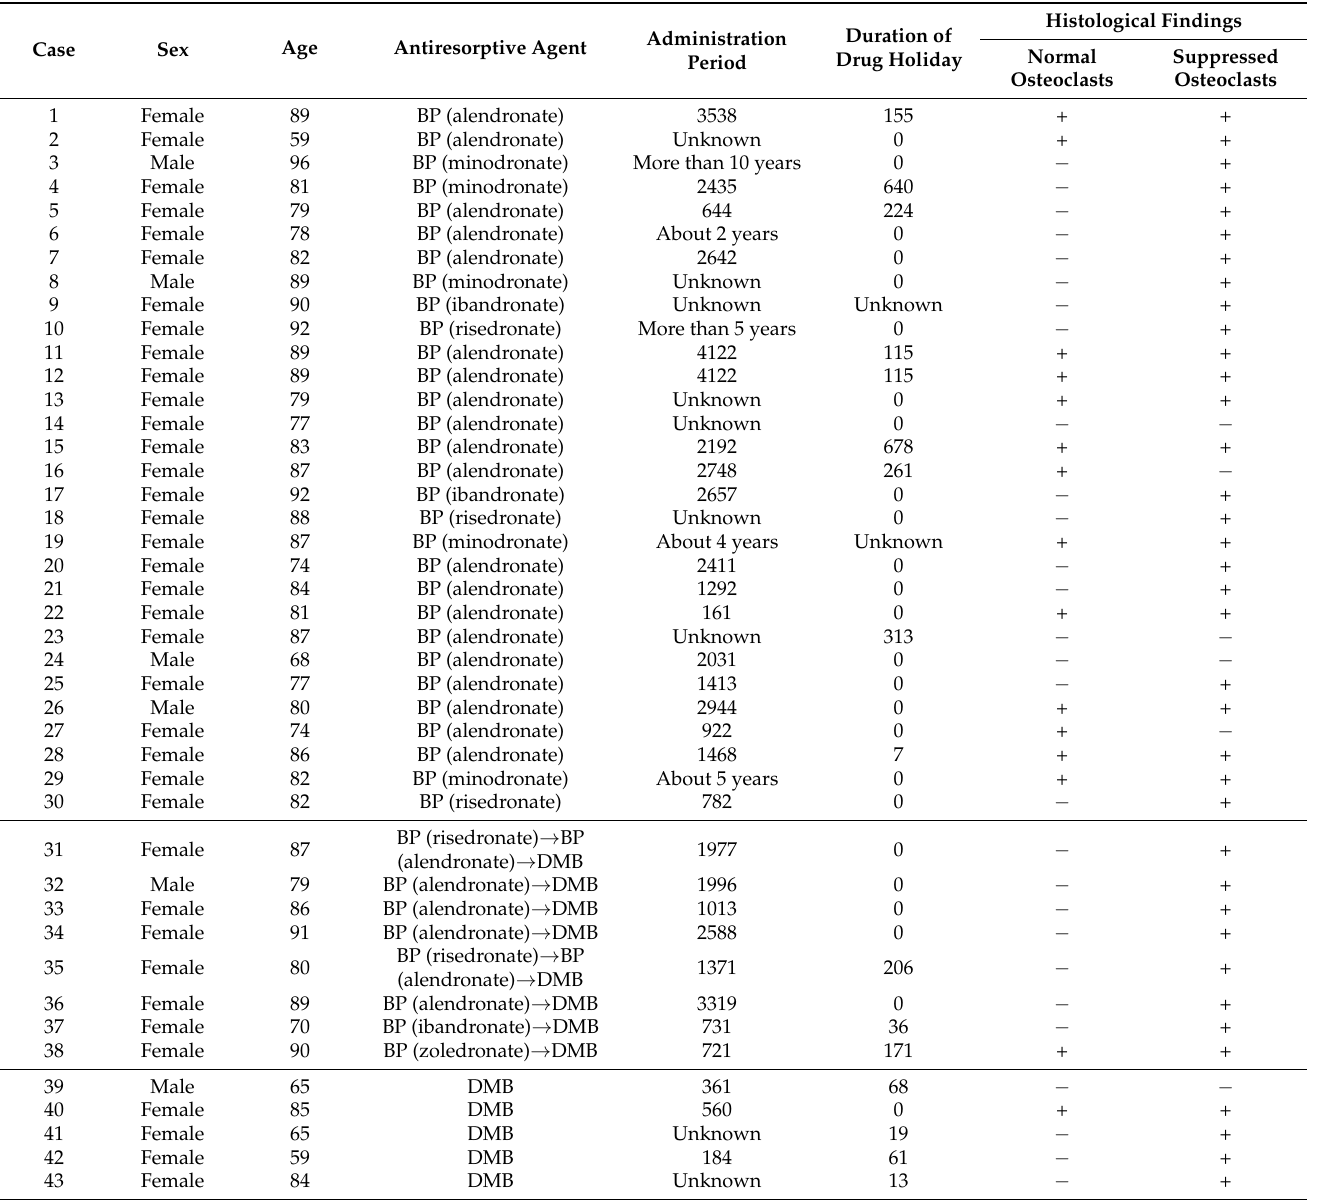
Table 7. Summary of histologic